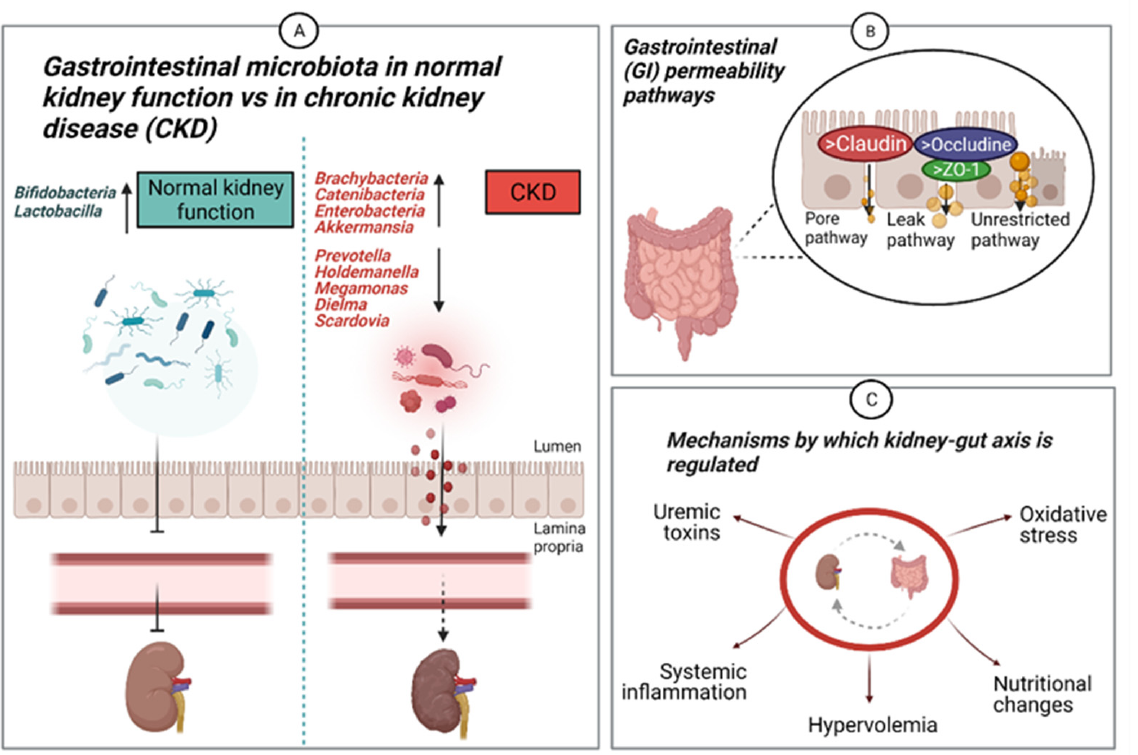
Figure 1. Schematic representation of intestinal microbiota in healthy ( left ) and CKD patients ( right ). ( A ) In physiological conditions, intestinal epithelial cells limit interactions between the gut microbiome in the intestinal lumen and the host. The TJ complex is intact, regulating the transport of selected molecules. ( B ) TJs control the paracellular permeability of ions, water, and macromolecules. Alteration of the TJ proteins involved in ion regulation leads to increased intestinal permeability. The unrestricted pathway is TJ-independent and reflects damage of epithelial cells. ( C ) In CKD, several different mechanisms alter gut microbiota composition leading to disruption of TJ and subsequent bacterial translocation across the gut barrier into the circulatory system, aggravating inflammation. C57Bl/6 mice are generally considered relatively resistant to CKD development after 5/6 nephrectomy, making them a good model for studying microbial changes over time. Luminal urea concentration was significantly increased after 5/6 nephrectomy, but was